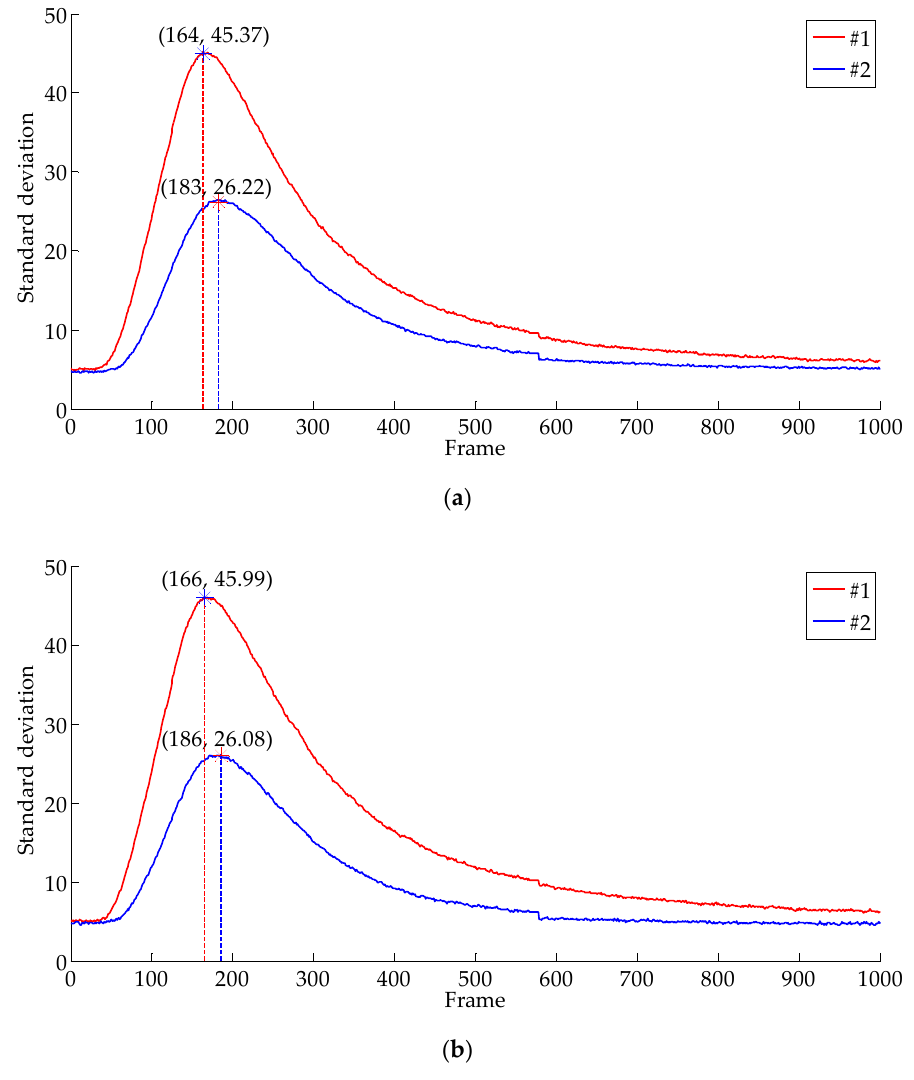
Figure 19. The MSDSRM to select a suitable frame for each defect: ( a ) Curves of standard deviation vs. time based on uniform selection of sensitive regions; ( b ) Curves of standard deviation vs. time based on random selection of sensitive regions.